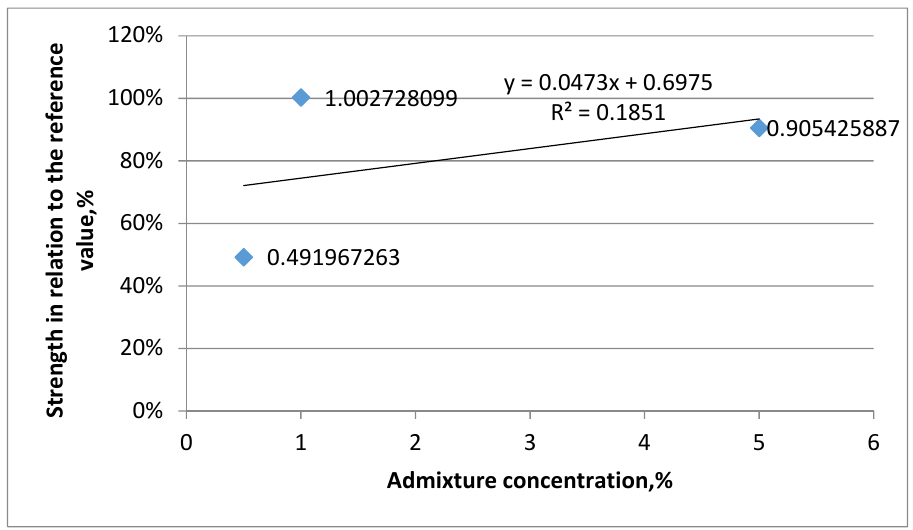
Figure 7. Compressive strength change depending on the type and amount of nanosilica additive— correlation analysis for cement slurry with nanosilica type 1.